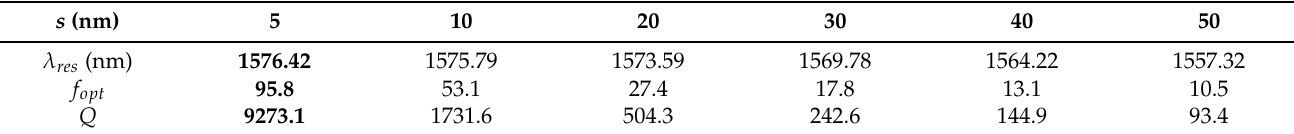
Figure 8. Normalized electric field distribution at 1576.42 nm for ( a ) XZ and ( b ) YZ. Table 2. Resonance wavelength λ res , Q and f opt varies for different s